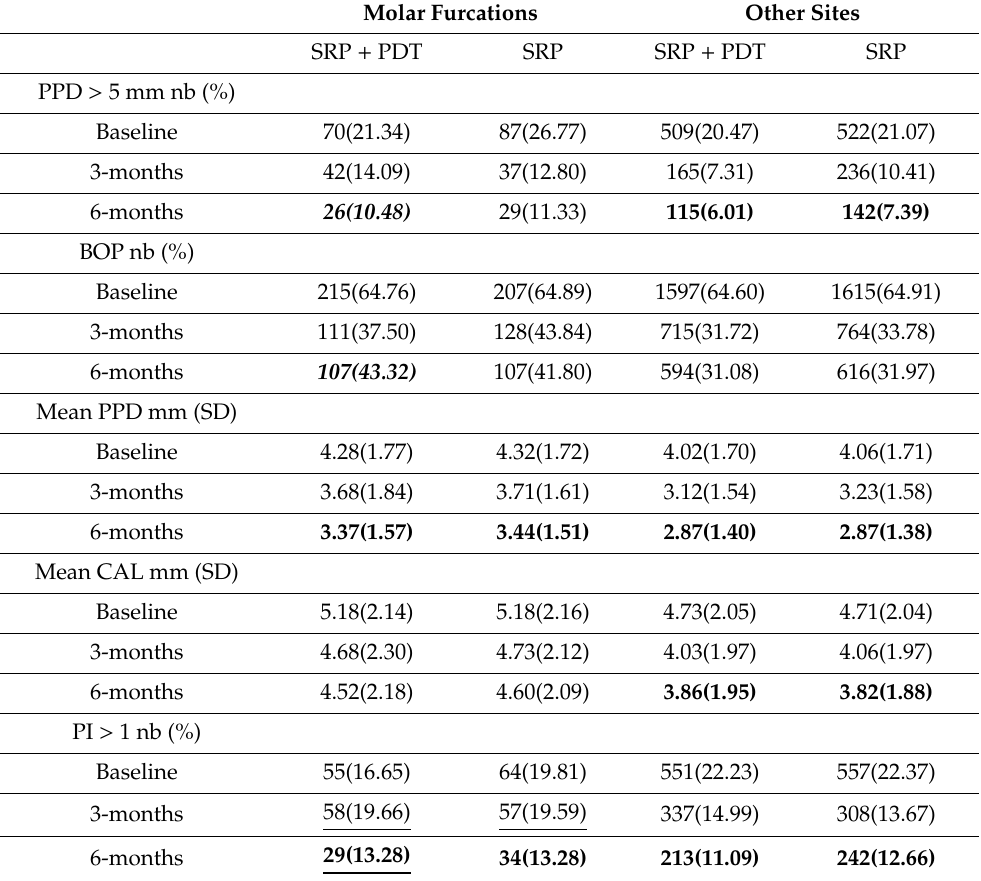
Table 2. Pockets > 5 mm, BOP, mean PPD, mean CAL, and PI in molar furcation sites and other sites at baseline, as well as at 3- and 6-months in SRP + PDT and SRP groups.